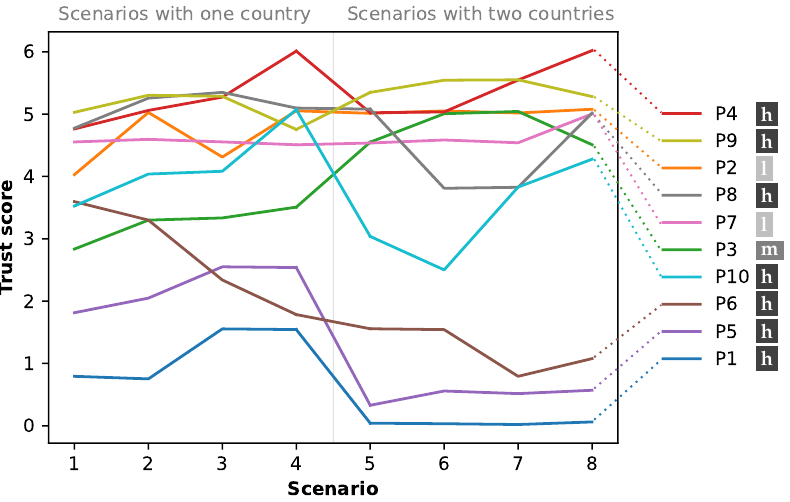
Figure 4. Participants’ trust in the prediction model over eight scenarios. Scenarios 1–4 showed data for one country; Scenarios 5–8 showed data for two countries. Lines are slightly jittered for clarity. The legend includes the level of experience with predictive regression ( l low, m medium, h